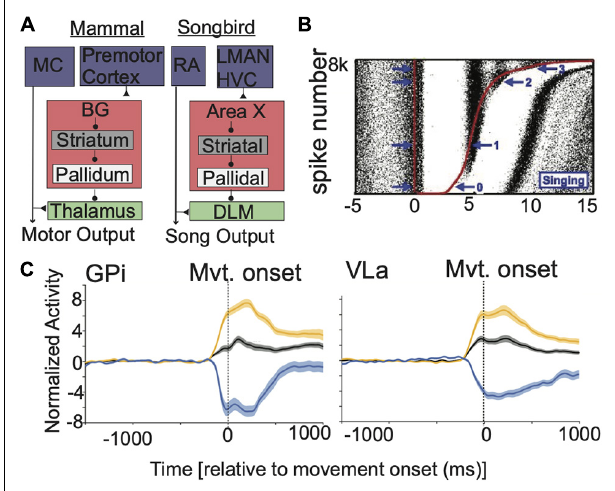
FIGURE 2 | BG output alters the timing of BG-Mthal spikes but not their average rate. (A) Comparative anatomy between mammalian and songbird BG-thalamocortical loops. Reproduced with permission from Goldberg et al. (2012). (B) Pallidal spikes regulate the fine timing of thalamic (DLM) spikes during birdsong. Red dots indicate pallidal spikes, rasters indicate thalamic spikes from a connected thalamic neuron. Trials are sorted by the duration of the pallidal interspike interval. Note that thalamic spiking is briefly suppressed after each pallidal spike, aligning thalamic spikes across trials but without reducing their overall firing rate on a longer time-scale. Reproduced with permission from Goldberg et al. (2012). (C) In NHPs performing reaches, response patterns are similar in GPi and VLa (an Mthal subregion with pallidal afferents). Population-averaged spike-density functions are shown for all neurons (black) for subpopulations that increase (orange) or decrease (blue) firing rates near movement onset. Shaded regions indicate SEM. Reproduced with permission from Schwab et al.